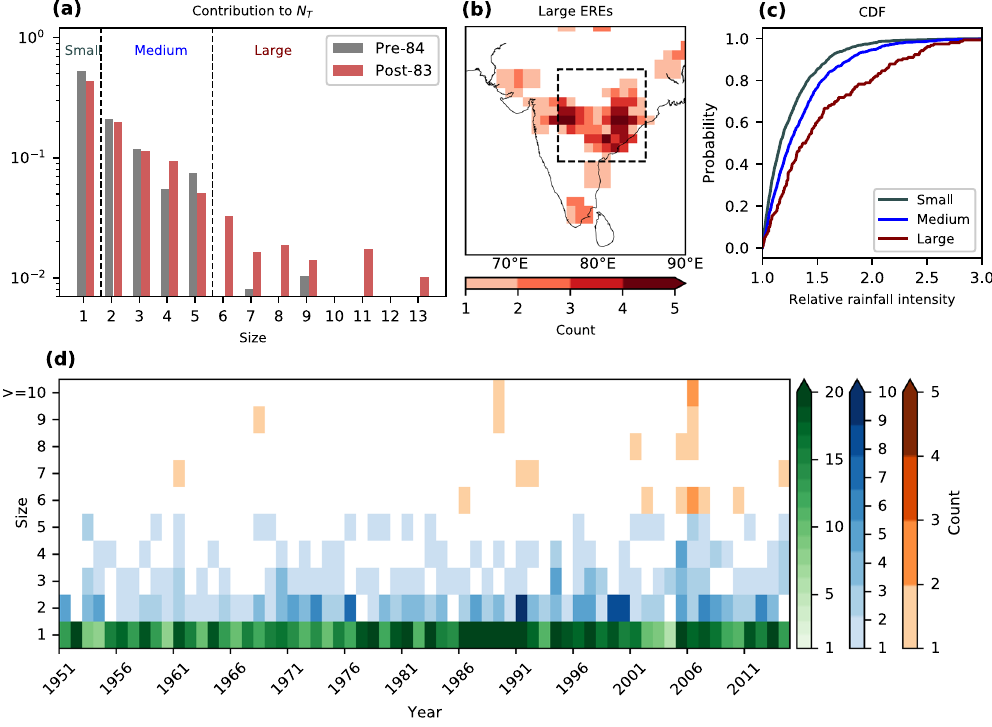
Figure 2. Characteristics of extreme rainfall events. ( a ) Contribution of the events of different sizes to the total number of grids having extreme rainfall events ( N T ) during the pre-84 (1952–1983) and post-83 (1984–2015) period. Based on the size, different types of events are defined as small (size 1), medium (size 2–5) and large (size ≥ 6) Extreme Rainfall Events (EREs). ( b ) Spatial distribution of large EREs. ( c ) Cumulative distribution function (CDF) of relative rainfall intensity of EREs. ( d ) Year-wise count of the extreme rainfall events of various sizes. The CDFs are significantly different from each other at the 99% confidence level (using the Kolmogorov– Smirnov test). The inset box in Fig. 2b indicates the study region (Central India: 15°–25°N,